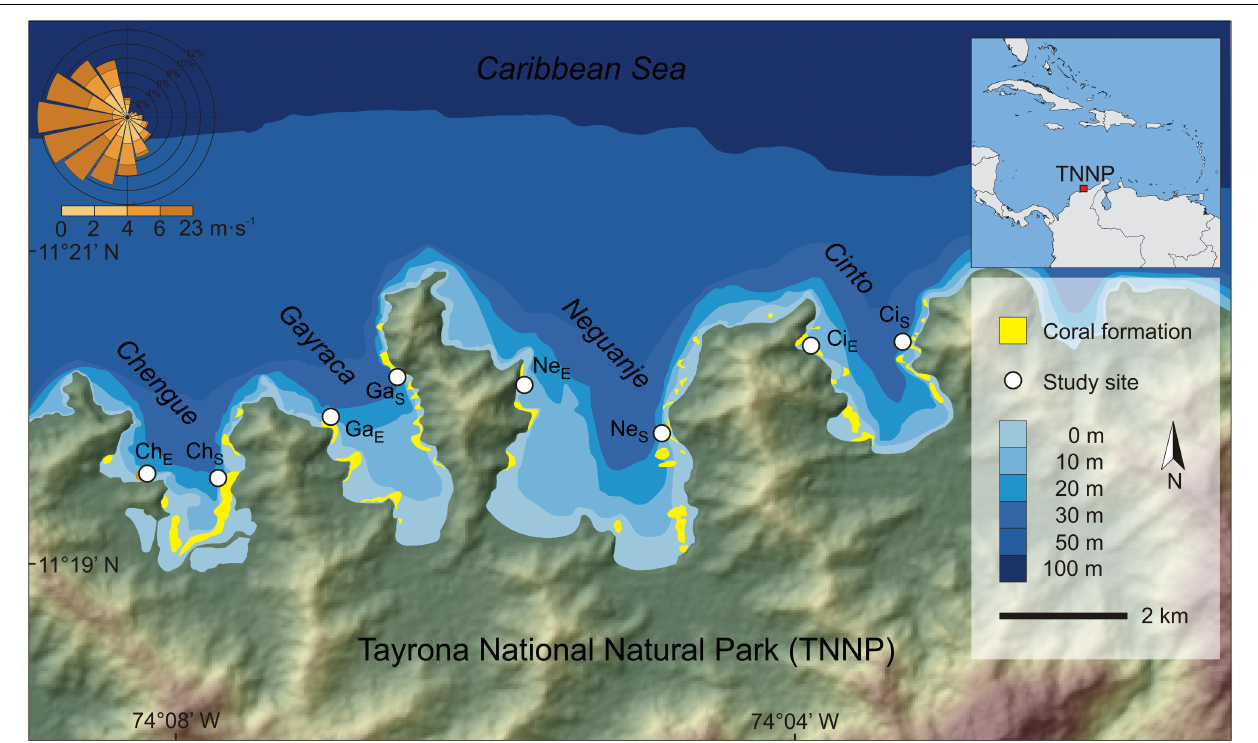
FIGURE 1 | Location of investigated bays in the Tayrona National Natural Park at the Caribbean coast of Colombia. White circles indicate study sites. Wind rose shows wind speed and direction for the area (QuickSCAT data, 1999–2008). Abbreviations of study sites: Ch S , Chengue sheltered; Ch E , Chengue exposed; Ci S , Cinto sheltered; Ci E , Cinto exposed; Ga S ,